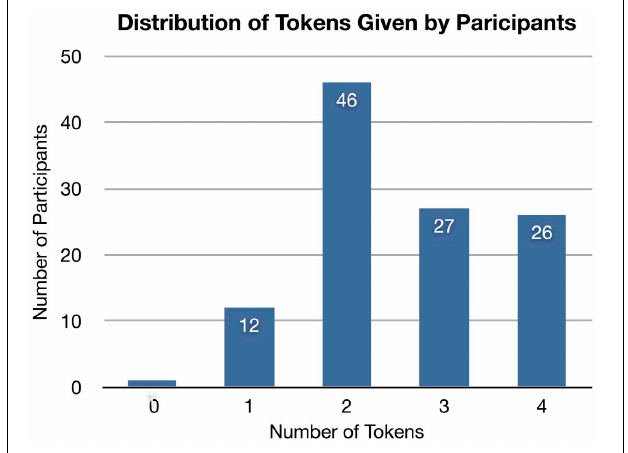
FIGURE 4 | The distribution of tokens given by participants. The majority (41%) gave two tokens. An a priori model based on this distribution will always predict two